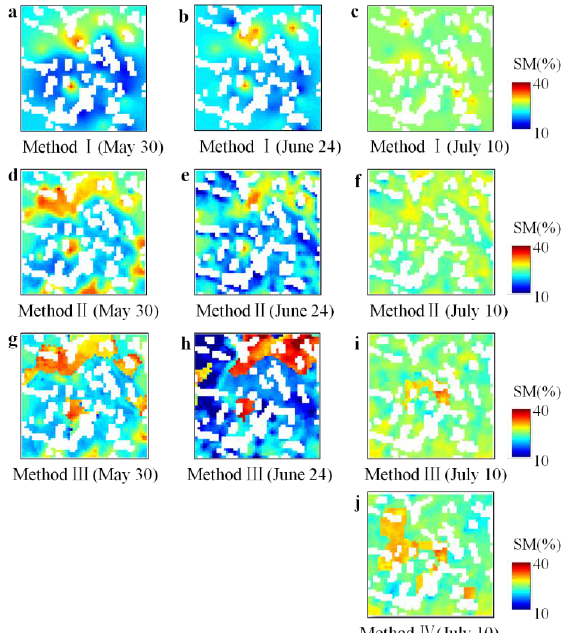
Figure 8. SM spatial distribution estimated by four methods with 90 m spatial